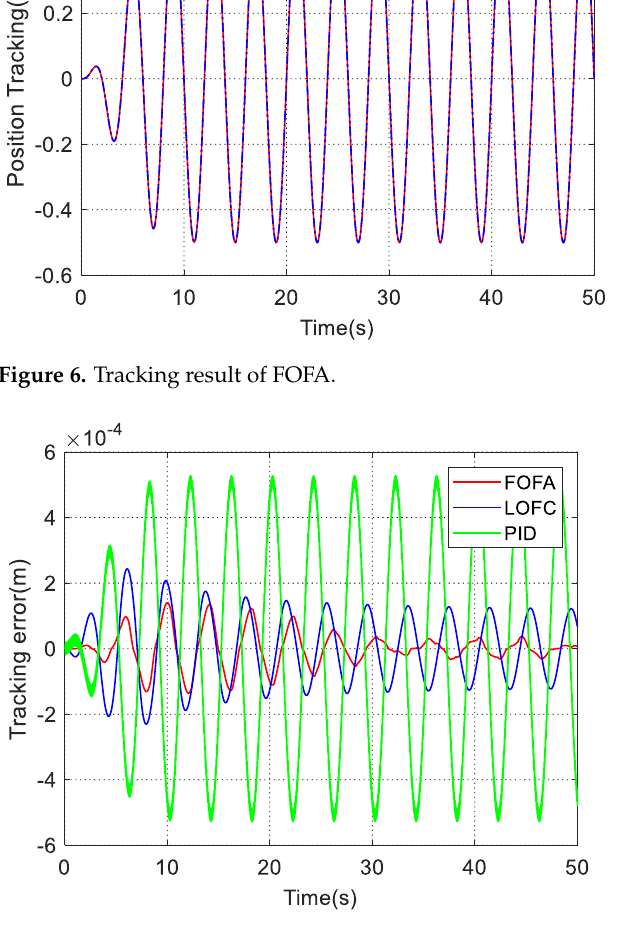
Figure 7. Comparison of position tracking error.